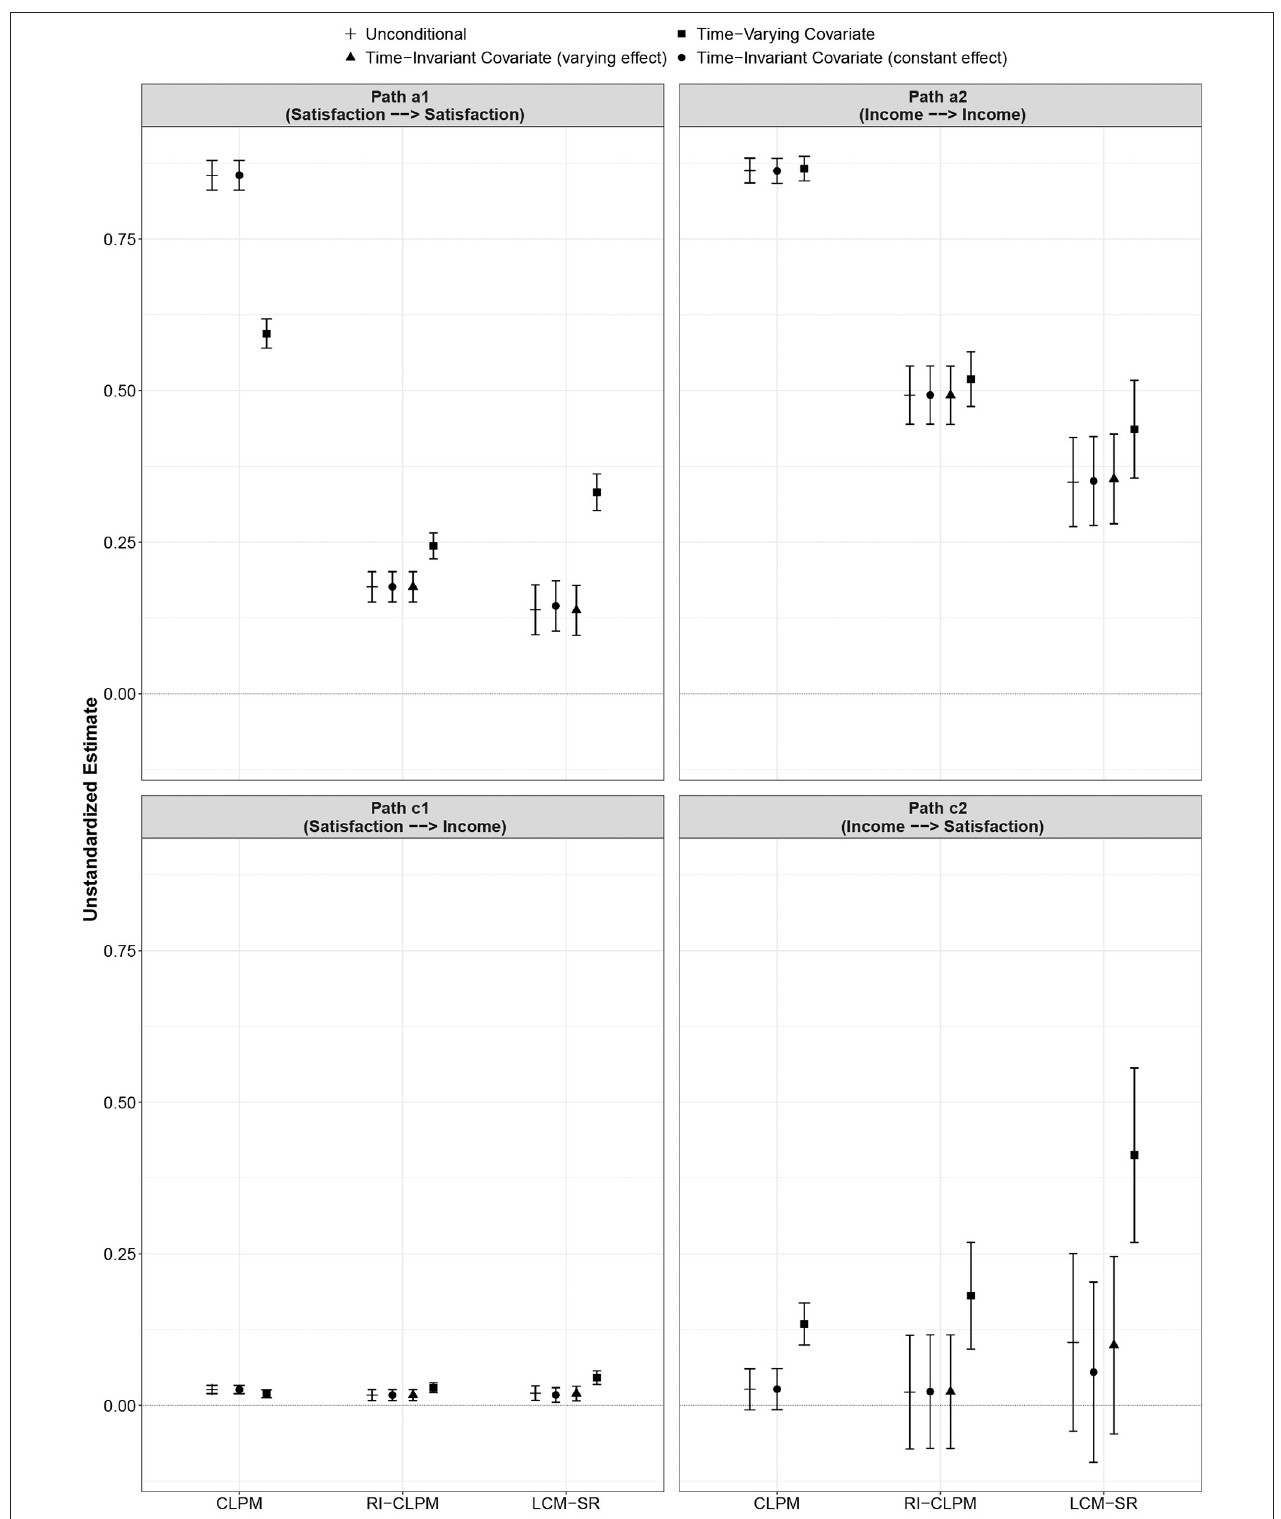
FIGURE 4 | Comparison of autoregressive and cross-lagged parameters across model specifications (unconditional, TIC, TVC) and between models (CLPM, RI-CLPM, LCM-SR). Error bars indicate 95% confidence intervals. Note that income was log-transformed for the analysis so that the scale is different from the scale used to measure life satisfaction. Figure is available under a CC-BY 4.0 license at https://osf.io/8mvu5/.